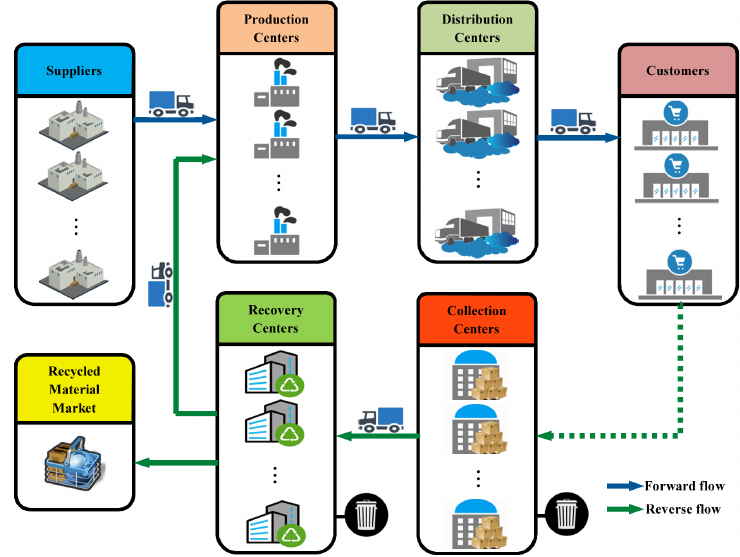
Fig. 1. Structure of the proposed supply chain